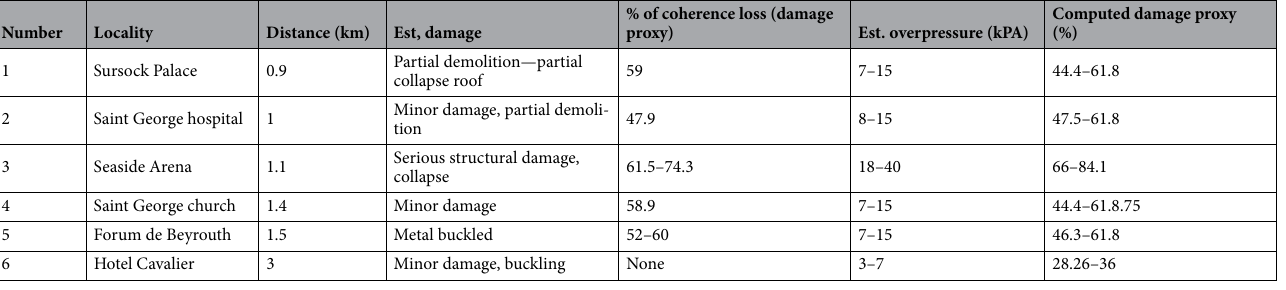
Table 4. Ground-truth used for validation of the relation between damage proxy inferred from InSAR data and the damage as function of peak-overpressure. See map of locations in Fig. 7. For each location the distance is given relative to explosion location and damage levels are estimated from available media coverage and reports 22,44,45 .